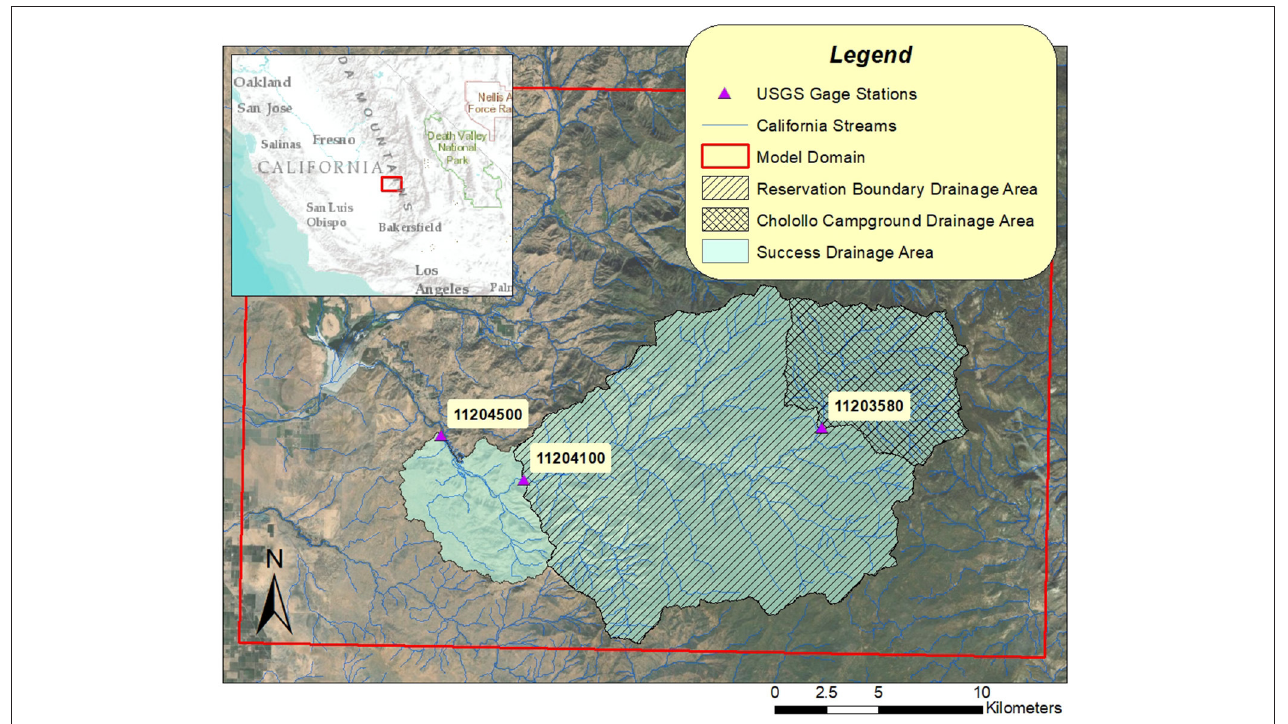
FIGURE 1 | Location and extent of model domain with calibration subwatersheds and corresponding USGS gage